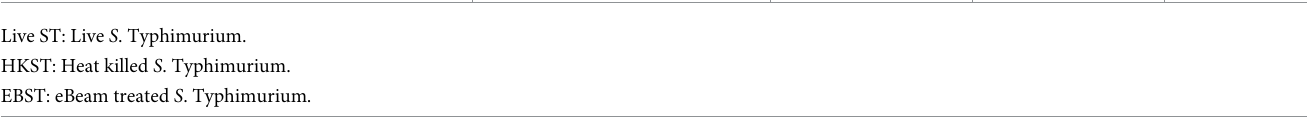
Catalase assay Bubble